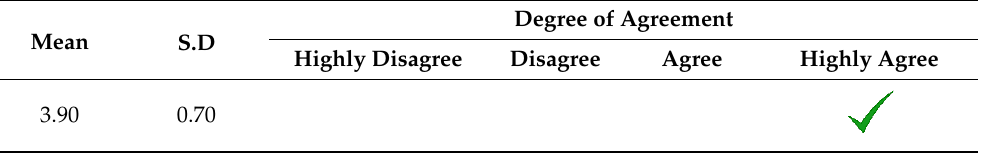
Table 3. Responses to Question 1-a. Table 4. Responses to Question 2-a.